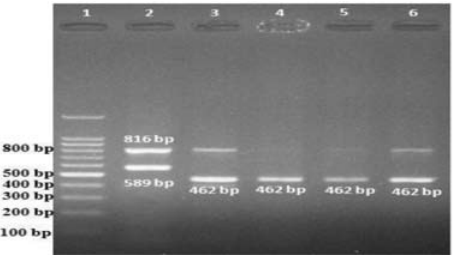
Fig.1 amplicons of